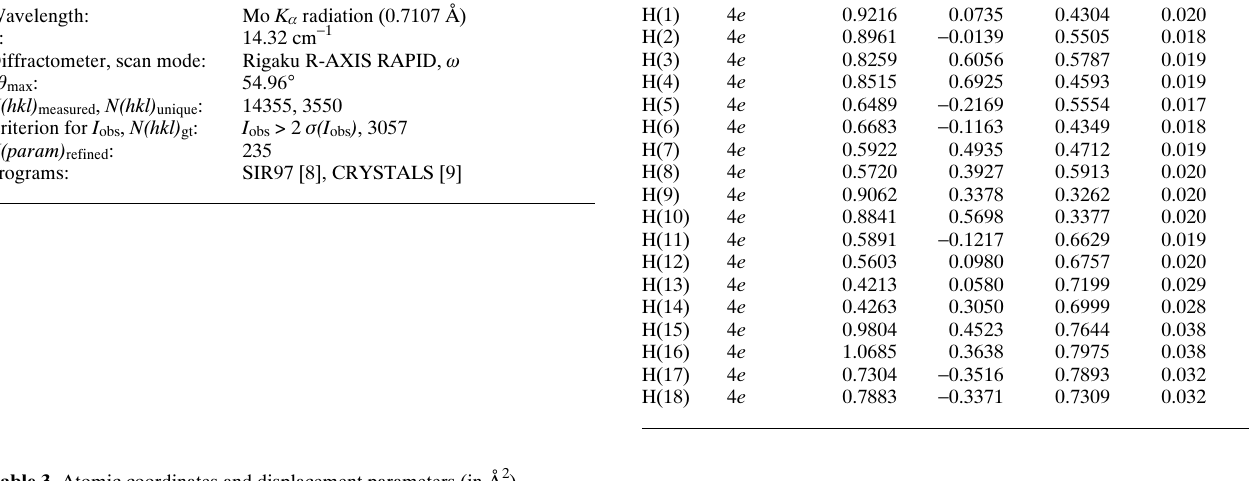
Table 3. Atomic coordinates and displacement parameters (in Å 2 ) .